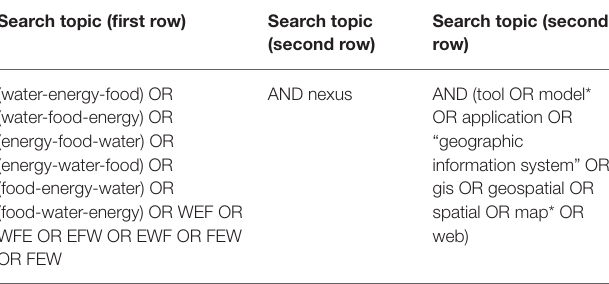
TABLE 2 | Search topics for retrieving documents related to WEF nexus tools in Scopus and WoS. Search topic (first row)